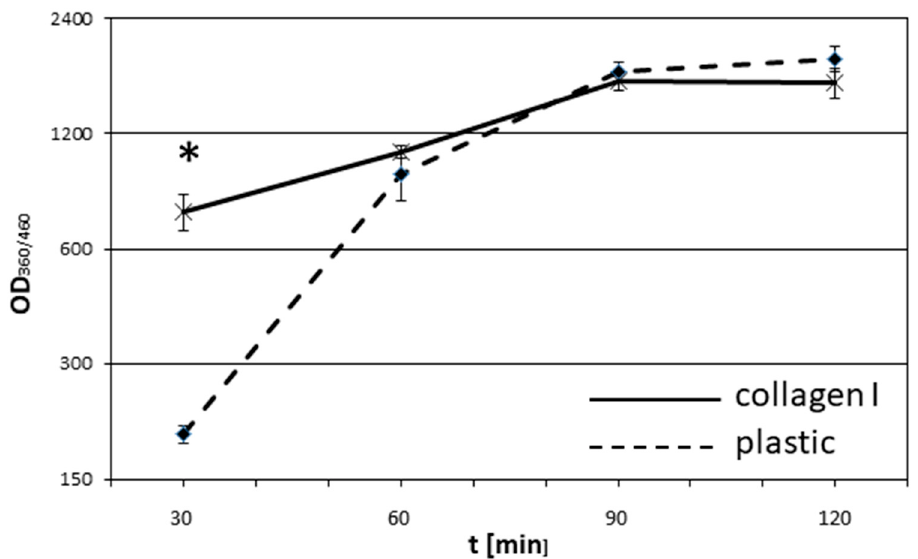
Figure 1. Quantitative adhesion of ASCs on plastic vs collagen I. ASCs were plated at a density of 1 × 10 4 cells per well into microtiterplates either non-coated or coated with collagen I. After 30, 60, 90, and 120 min, non-adherent cells were discarded and the remaining cells were stained with bisbenzimide. Fluorescence, as a measure for adherent cells, was quantified using a CytoFluor multi-well plate reader at 360 / 460 nm. Each point represents the mean of five independent experiments. The standard deviations are indicated. * p < 0.05. The whole experiment was repeated three times with similar results.